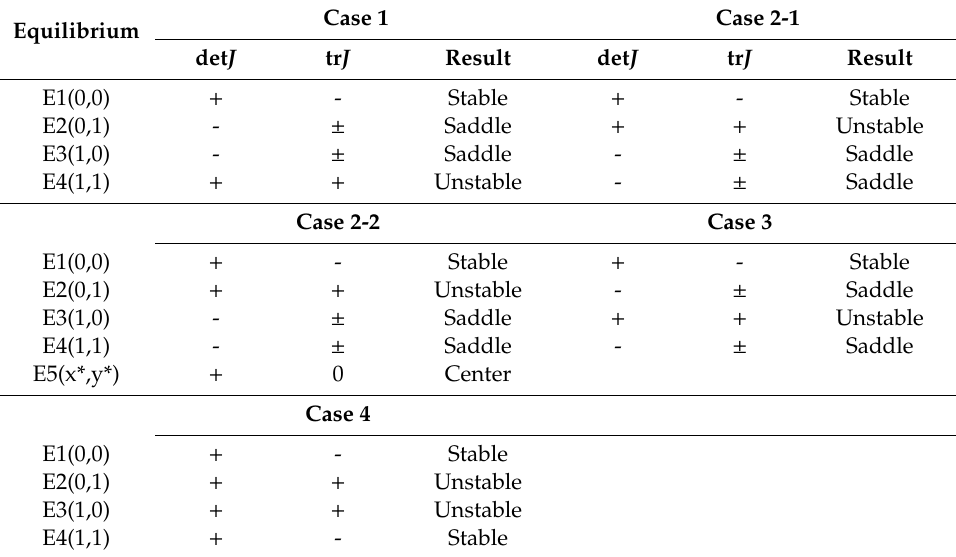
Table 6. Proposition 1: Analysis of local stability of equilibrium.